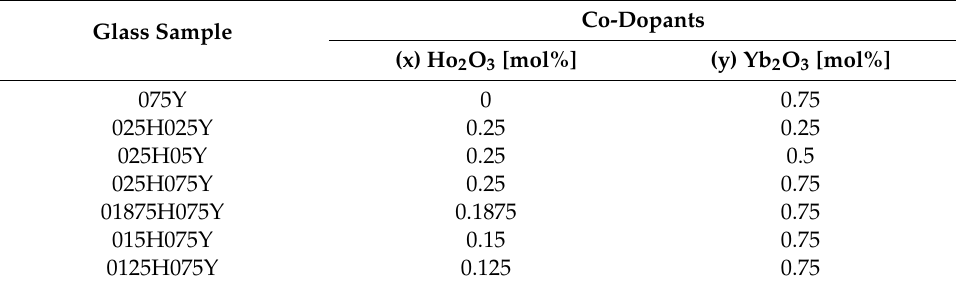
Table 1. The molar percentage of holmium and ytterbium oxides co-dopants. Glass